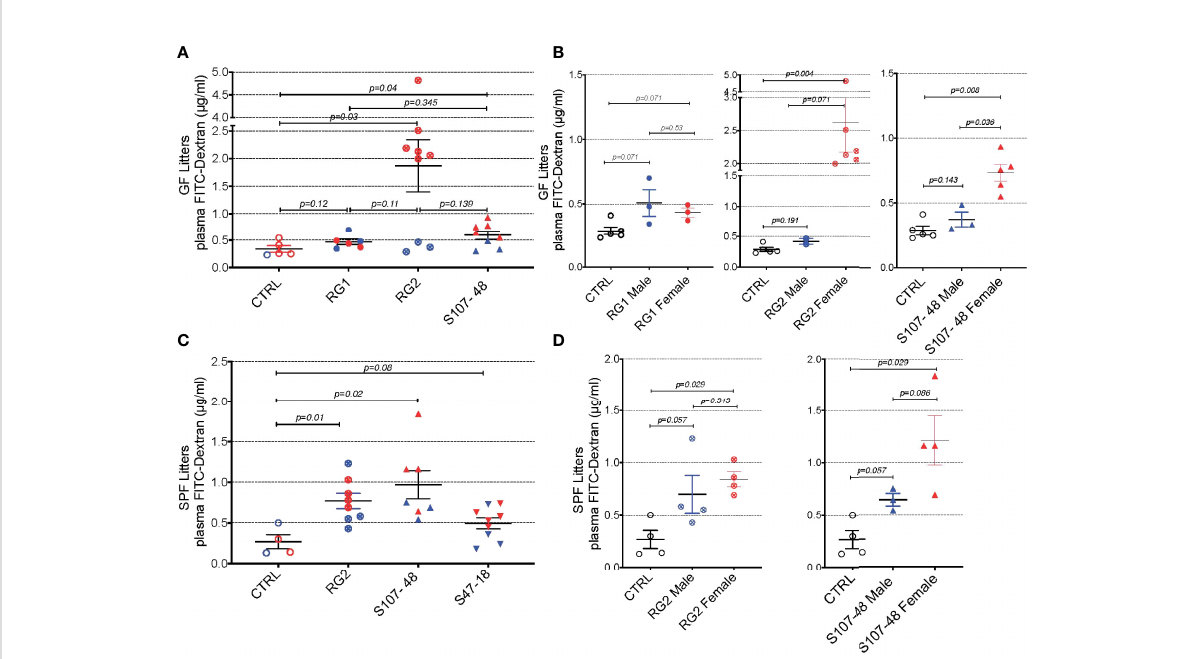
FIGURE 4 Intestinal colonization of GF and SPF mice by select RG strains induces enhanced intestinal permeability. (A) Neonatal intestinal colonization of the litters of GF mice by RG strains, RG2 and S107-48 but not the RG1 strain, induces increased intestinal permeability when tested by the FITC- dextran challenge assay in mice at 10-14 weeks of age. (B) Higher levels of intestinal permeability were found in RG2 and S107-48 strain colonized females than male littermates. (C) Litters of SPF mice that were colonized by the RG strains, RG2 and S107-48, displayed increased intestinal permeability. Due to heterogeneity in responses, the group colonized by the S47-48 RG strain did not attain signi fi cance. (D) Female mice colonized with RG2 and S107-48 displayed signi fi cantly greater levels of intestinal permeability than male mice or non-colonized control mice. Results indicate mean ± SEM (n= 3- 6 mice per group). In some cases mice were lost to unwitnessed deaths. Comparisons by unpaired t test, p values shown. Control received sham instillations with sterile